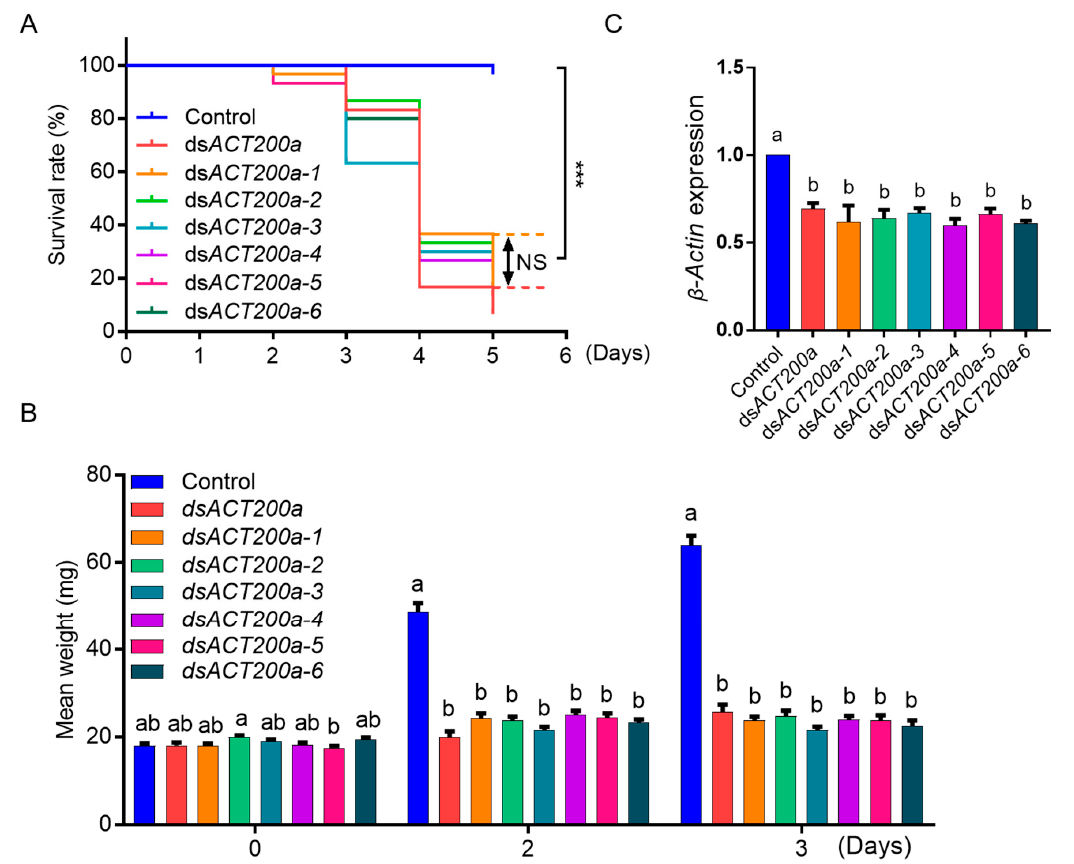
Figure 2. RNAi e ff ects on Colorado potato beetle (CPB) larvae fed with di ff erent in vitro synthesized dsRNA variants. ( A ) Kaplan-Meier survival curves of third-instar CPB larvae fed with potato leaves that had been painted with identical amounts (4 ng / cm 2 ) of indicated ds ACT s. The log-rank test was used to assess the significance of di ff erences between two survival curves. *** p < 0.001; NS, not significant. ( B ) Mean weight of surviving CPB larvae at the indicated days of feeding. Data are means ± SE (n = 30). ( C ) Relative expression levels of β -Actin in the CPB larvae in ( A ) at day 3. Gene expression levels were set as one in CPB larvae fed with H 2 O-painted control leaves. Data are means ± SE (n = 3). The letters above each bar in ( B , C ) indicate the significance of di ff erences as determined by one-way ANOVA in SPSS (Bonferroni’s test, p < 0.05).